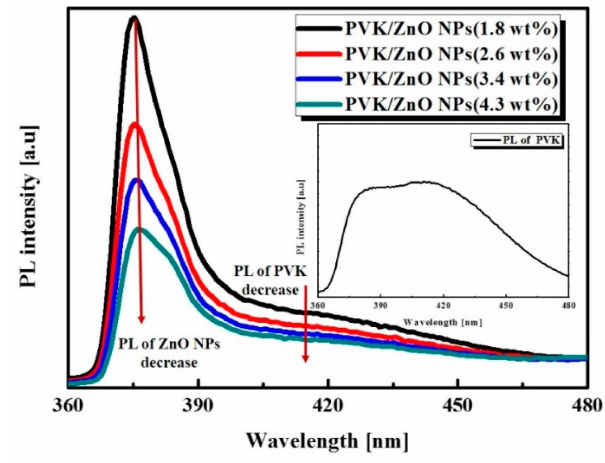
Figure 5. PL spectra of PVK /ZnO NPs hybrid composites and inset image is PL properties of